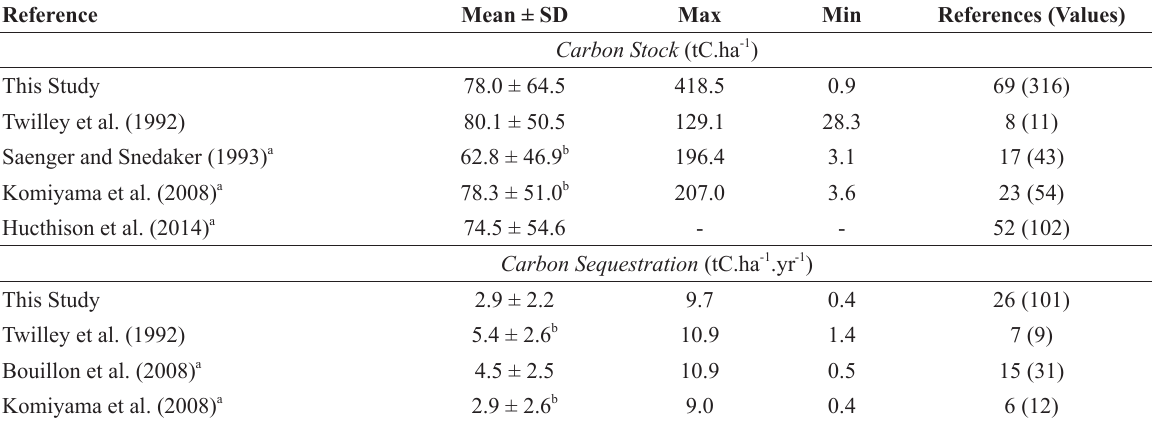
Global estimates of carbon stock and sequestration in the aboveground biomass of mangroves found in the literature and number of references and values compiled by each